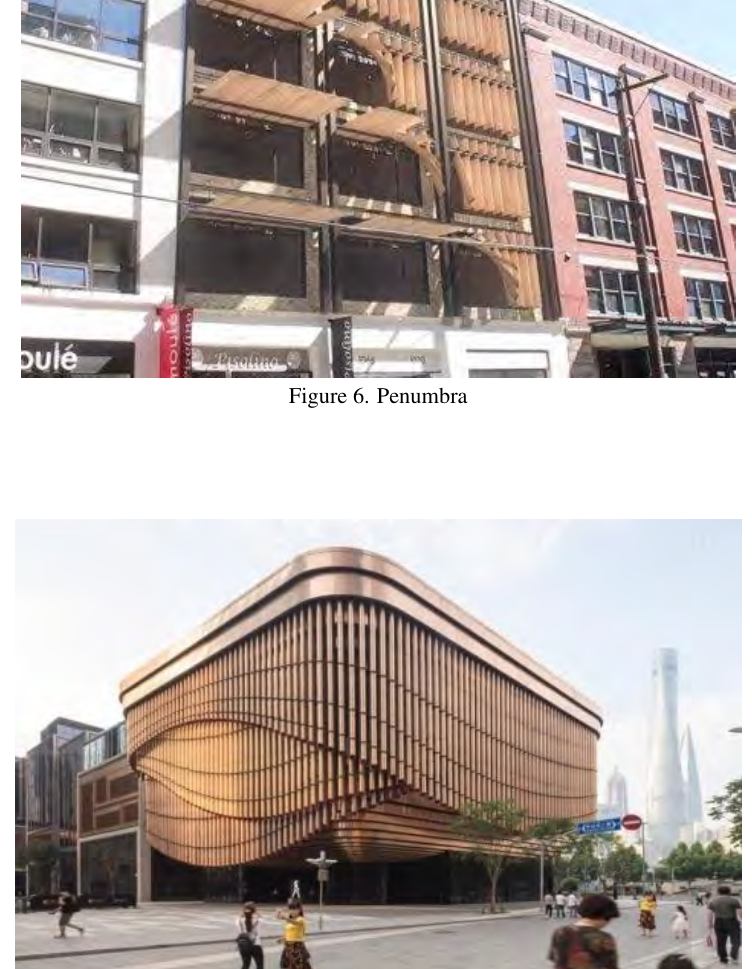
Figure 7. Shanghai theater